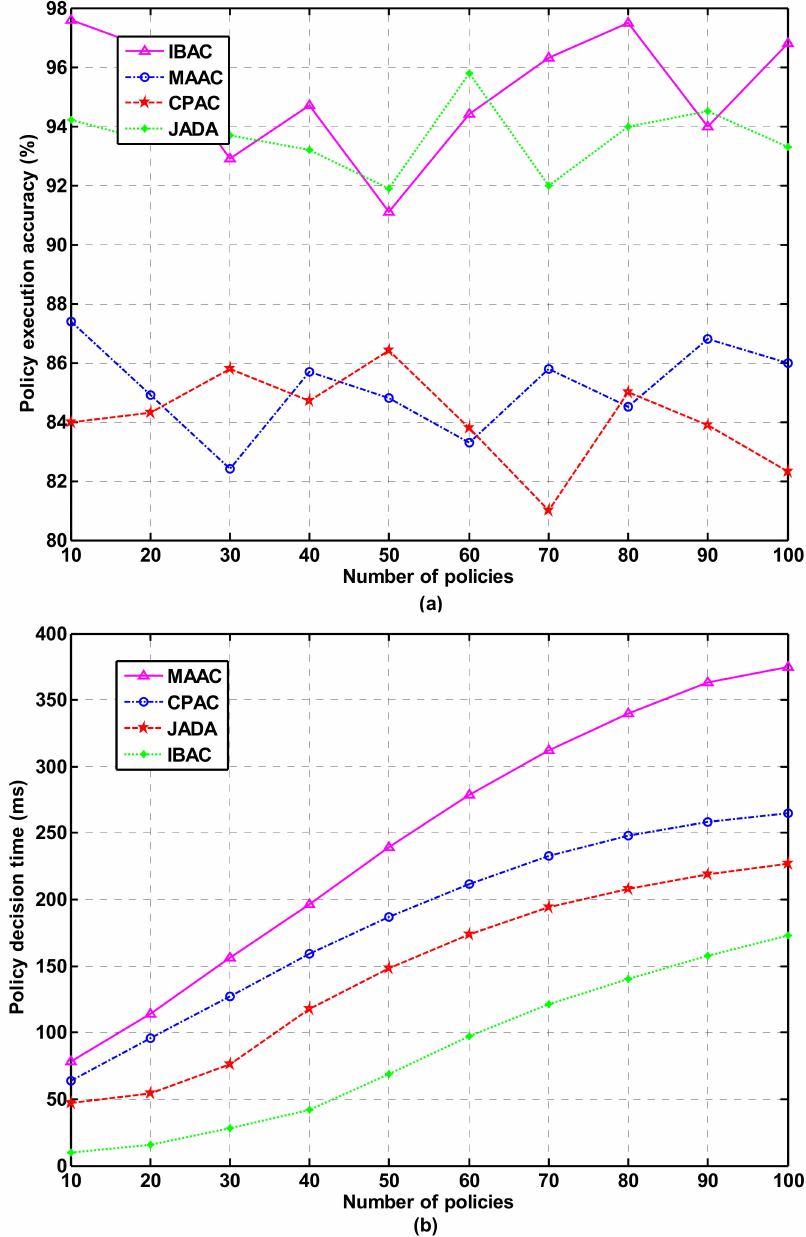
Figure 5. Policy execution accuracy and policy decision time in sensor networks. ( a ) Policy execution accuracy; ( b ) policy decision